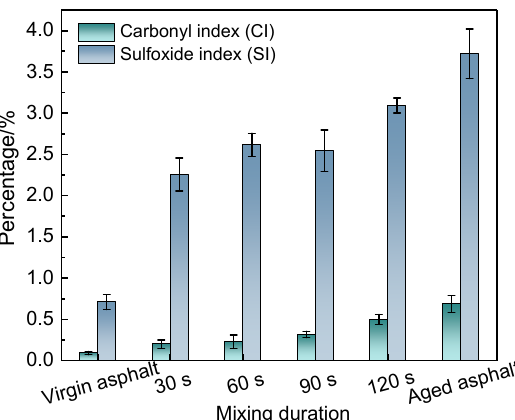
Figure 11. Infrared spectra of the asphalt binder with different mixing durations. To evaluate the degree of blending of the asphalt binder containing aged and virgin asphalt in the FTIR test, the bond index ( CI and SI ) was calculated using Equations (2) and (3). Figure 12 shows that the carbonyl index CI and sulfoxide index SI were significantly increased after mixing at different times, with an increase of 116.4% and 218.3%, respectively, compared to the virgin asphalt. The carbonyl index CI and sulfoxide index SI in the virgin asphalt were the smallest, while the aged asphalt had the highest indexes. In addition, the range of increase of the carbonyl index CI and sulfoxide index SI in the blended asphalt decreased with the increase in the mixing duration.